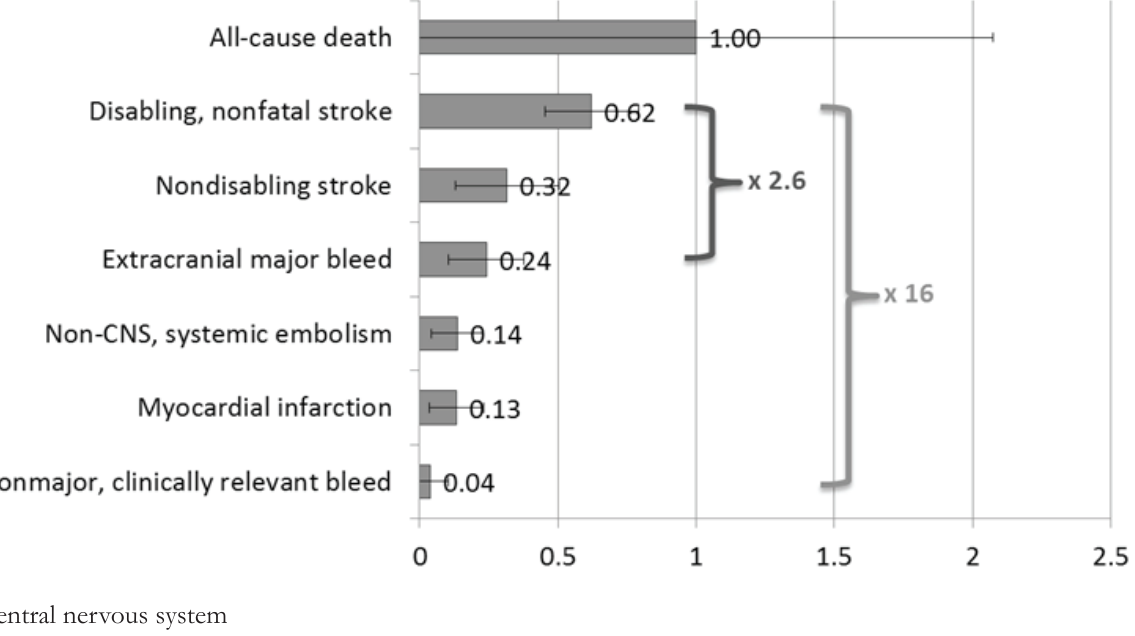
Figure 2. Patient Importance Weights (n = 152) Importance weights normalized relative to all-cause death and 95% confidence interval corresponding to a 3-percentage- point change in the incidence of each event. Apart from all-cause death, all events are